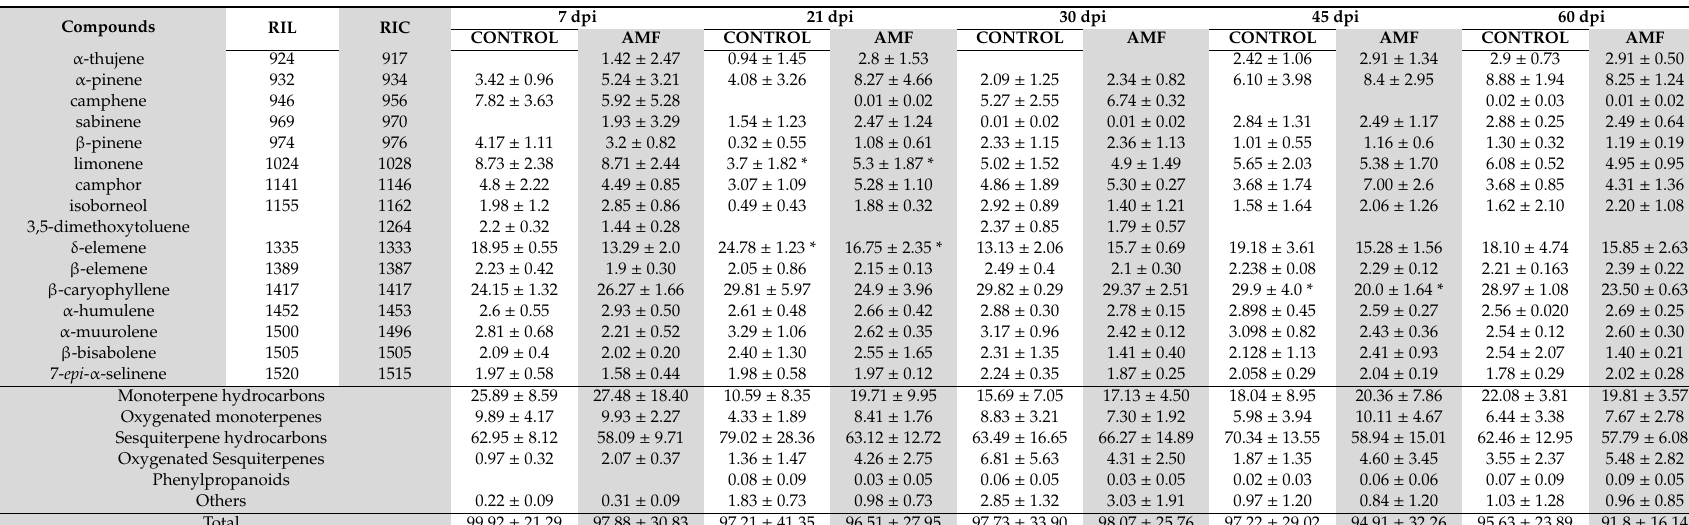
Table 2. Comparison of volatile compounds produced in Piper nigrum roots non-inoculated and inoculated with arbuscular mycorrhizal fungi (AMF) (mean ± standard